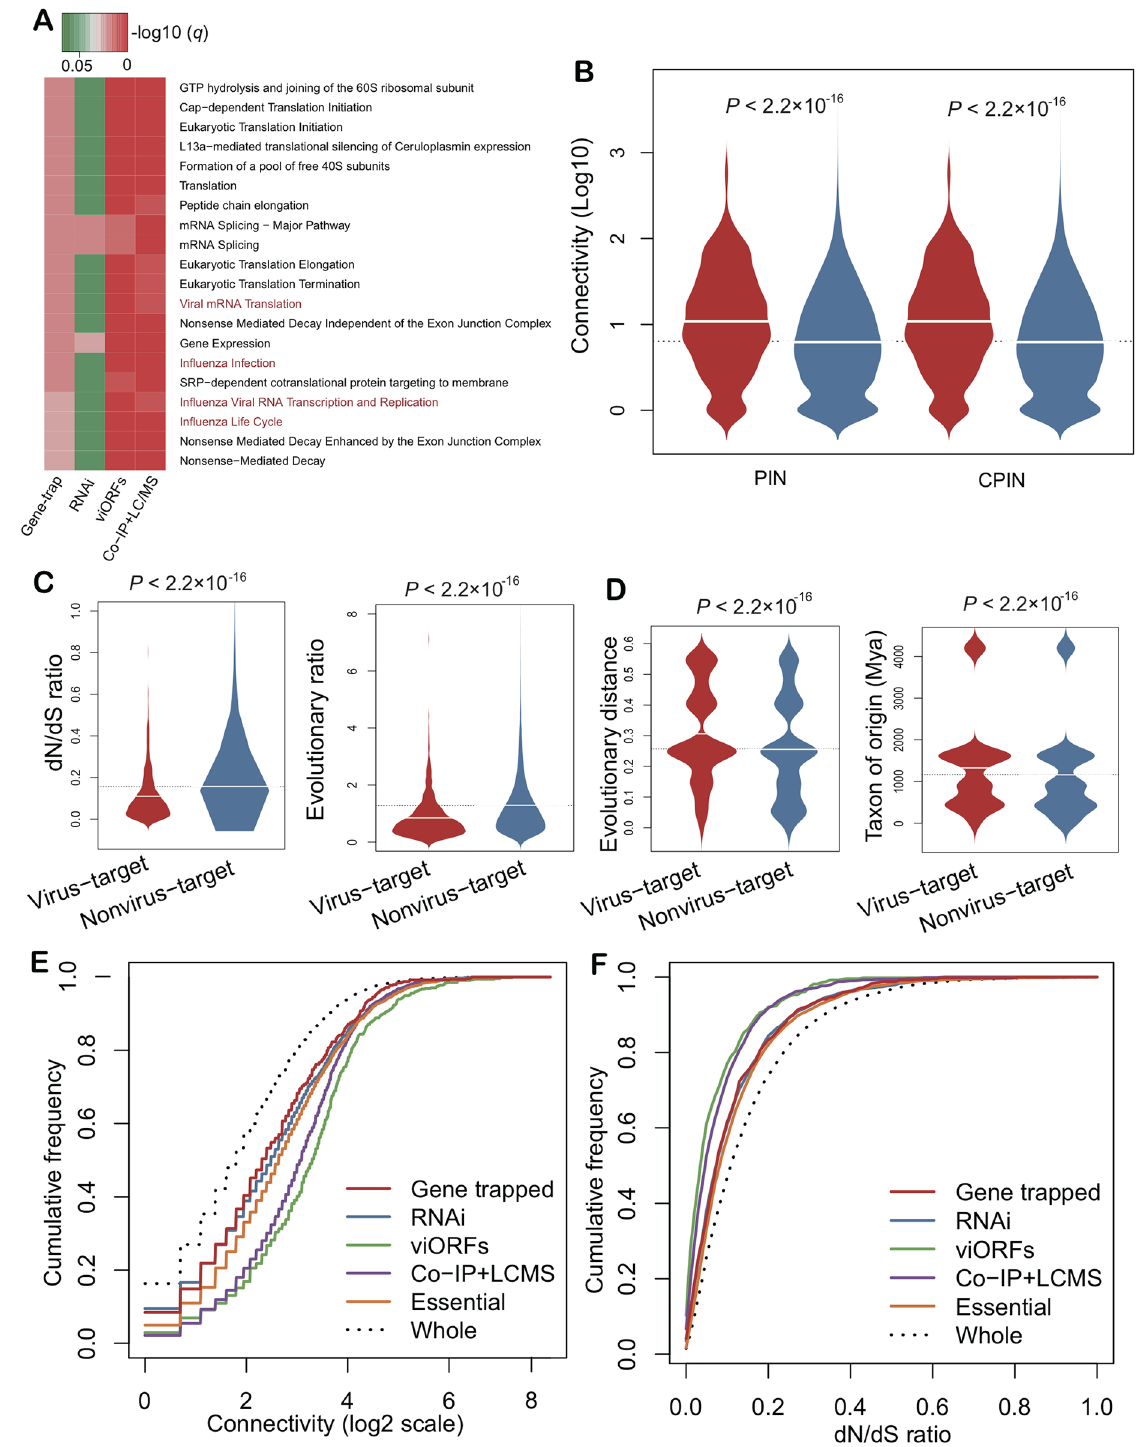
Fig 3. Bioinformatics analysis and network topological and evolutionary characteristics of host genes mediating viral replication. ( A ) Reactome pathway enrichment analysis of four different host cellular gene sets identified by gene-trap insertional mutagenesis (trapped genes), previous RNA interference (RNAi) screening studies, viral open reading frames (viORFs), and co- immunoprecipitation and liquid chromatography-mass spectrometry (Co-IP+LC/MS) (S1 Table). ( B ) Boxplots showing the connectivity distribution of virus host genes (red) versus non-virus-host genes (light blue) in the physical protein interaction